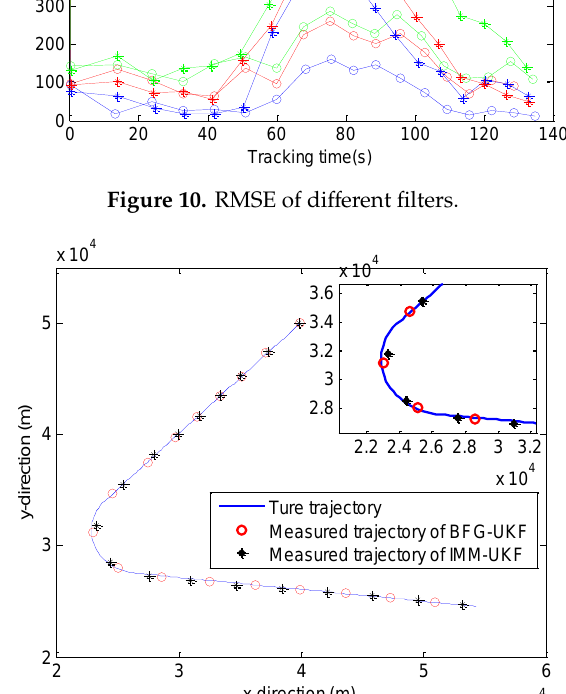
Figure 10. RMSE of di ff erent filters.